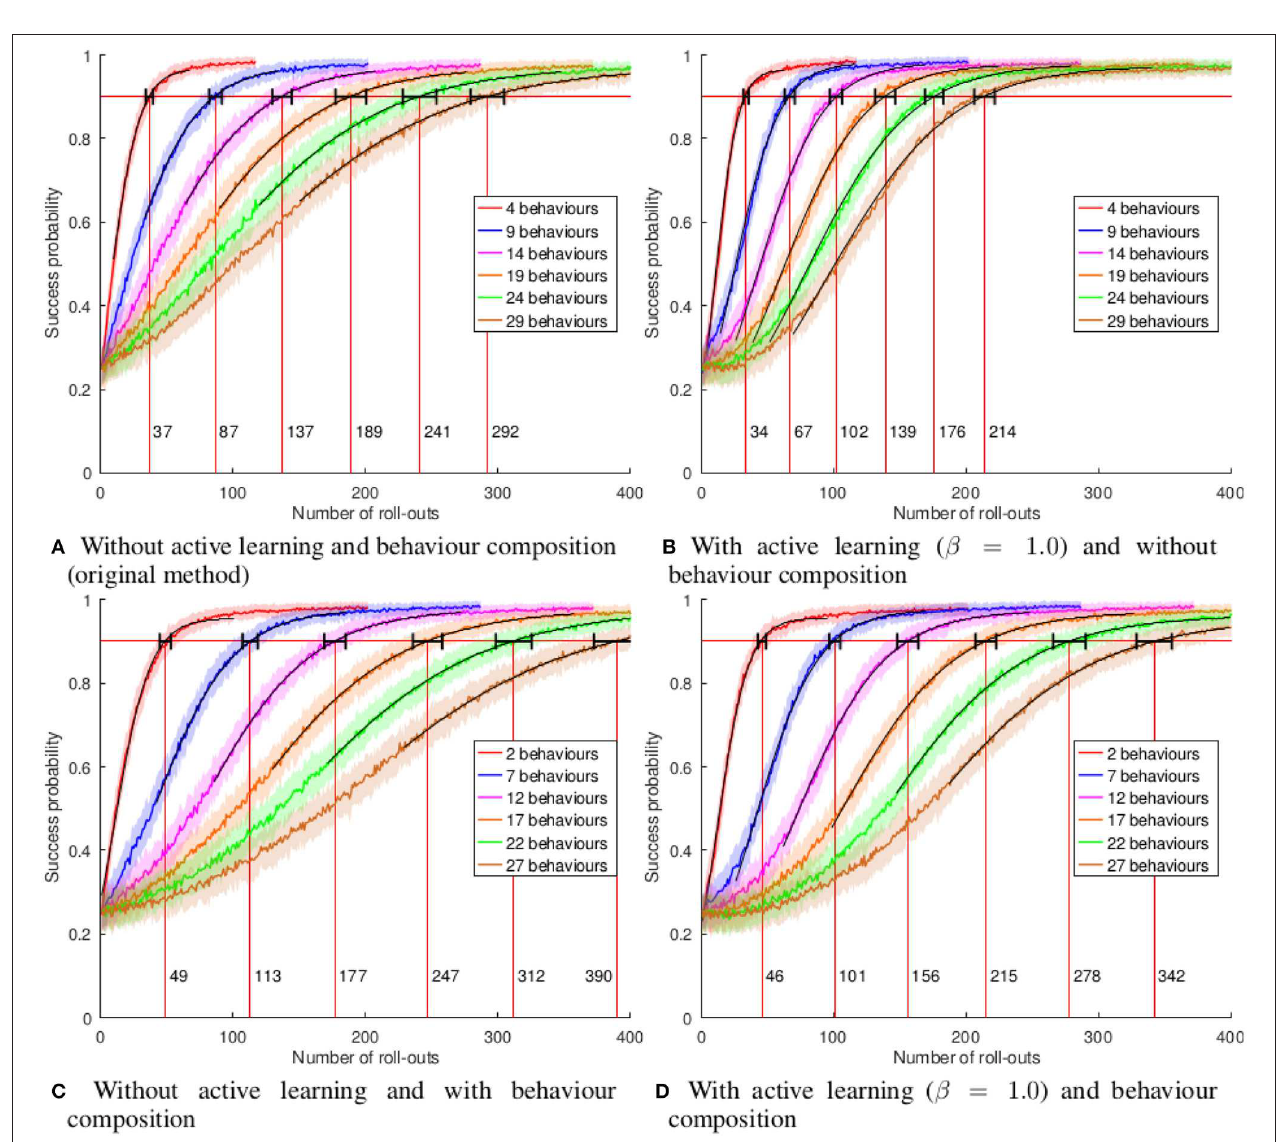
FIGURE 7 | Evolution of the simulated success rates over the number of rollouts for different numbers of preparatory behaviors. For each curve from left to right, five behaviors are added. The red horizontal lines denote an average success rate of 90%. The total number of behaviors is given by J = J changing + J stable , where J changing denotes the number behaviors that change the perceptual state and J stable denotes the number of behaviors that leave the perceptual state unchanged. Without behavior composition we chose J changing = 4 so that the target state can be reached from every state. With behavior composition we chose J changing = 2 (one behavior to hop to the next state and the void behavior) which makes both settings equally expressive. Note that the setting with behavior composition is significantly harder as not all required preparatory behaviors are available to the robot. To robustly estimate the point of convergence, a sigmoid model of the form sig [ c 1 − c 2 x ] + c 3 (plotted in black) was fit for the interval [ x conv − 1 x , x conv + 1 x ] of each curve. x conv is the first point for which the average success rate surpasses 0.9 and 1 x is 25% of the total length of the curve. (A) Without active learning and behavior composition (original method). (B) With active learning ( β = 1.0) and without behavior composition. (C) Without active learning and with behavior composition. (D) With active learning ( β = 1.0) and behavior composition.